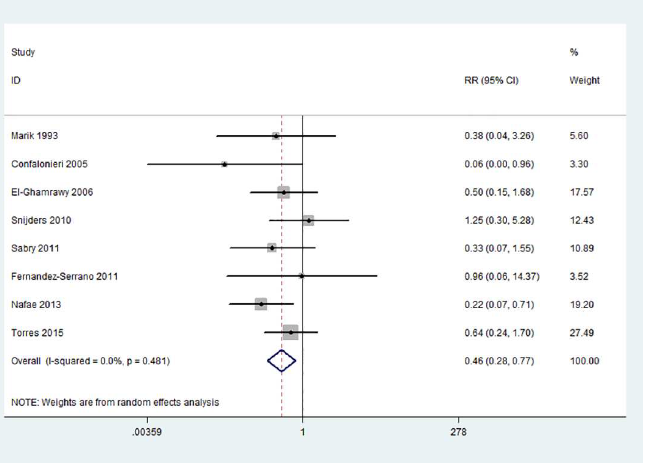
Fig 2. Forest plots of the association between all-cause mortality of severeCAP and